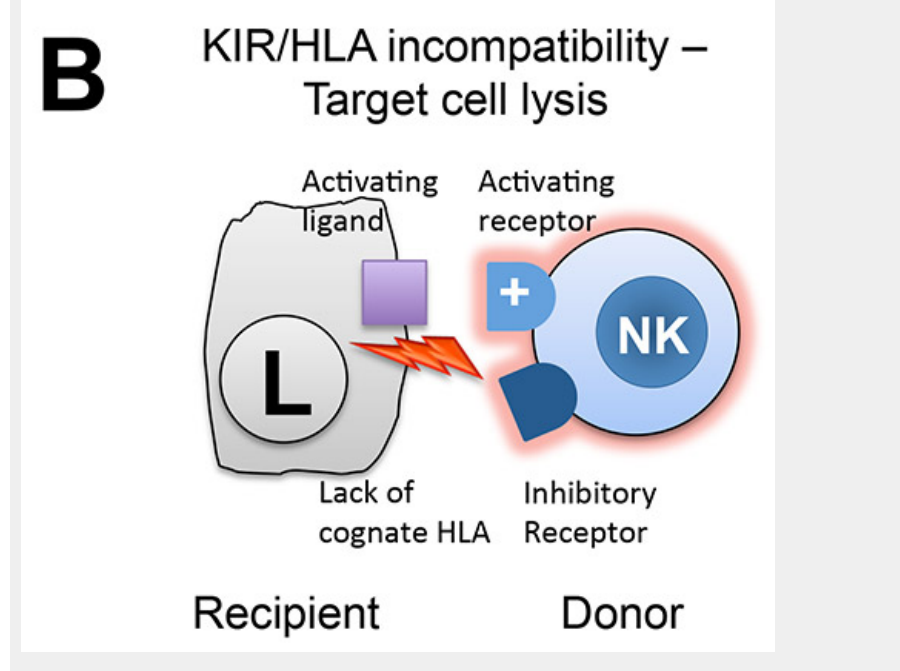
Figure 1 NK cell alloreactivity after haploidentical stem cell transplantation is determined by the HLA class I antigen/KIR constellation of donor and recipient. Donor NK cell activating and inhibitory receptors interact with ligands on recipient target (leukaemia) cells. The activation state of NK cells is determined by the integration of both types of signals. In the case of KIR/HLA compatibility, the inhibitory signal dominates and induces tolerance (panel A). In the absence of a cognate HLA ligand, activating signals dominate and lead to target cell lysis (panel